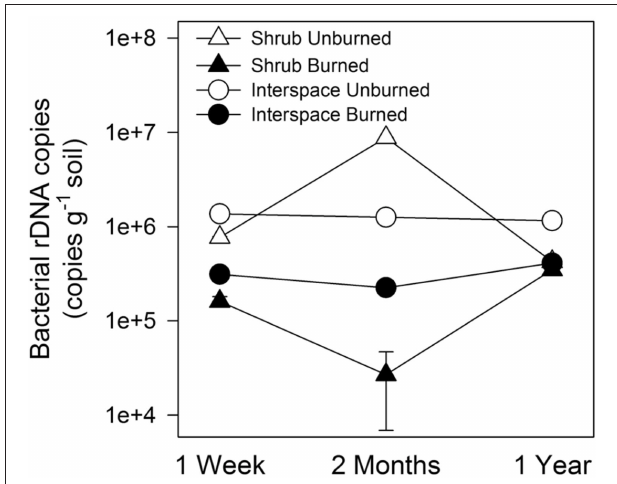
FIGURE 4 | Bacterial biomass declined following fire in both biocrust types. Values are means ( n = 2–3) ± SEM, measured with quantitative polymerase chain reaction (qPCR) and reported as rRNA gene copy number. Differences between burned and unburned soils through time are based on two-way, repeated-measures